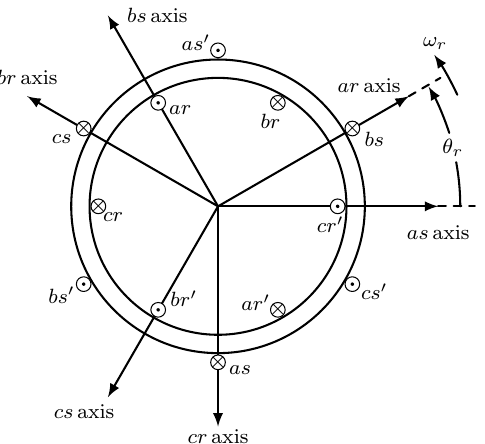
Figure 3. Cross section of a three-phase, two-pole induction